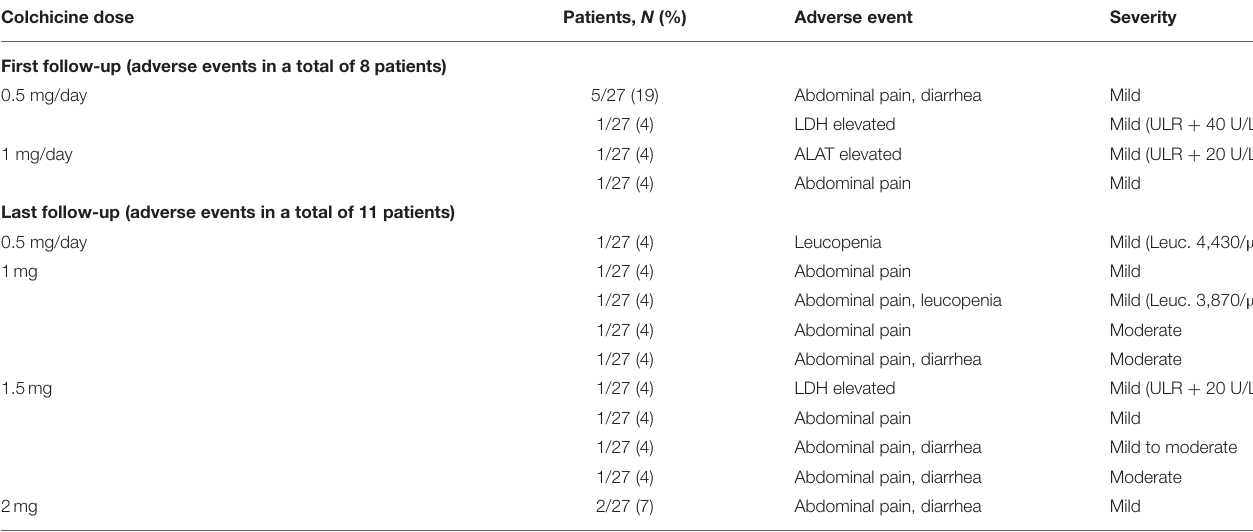
TABLE 4 | Colchicine safety: adverse event dose relationship in 27 PFAPA patients. Colchicine dose Patients, N (%) Adverse event Severity First follow-up (adverse events in a total of 8